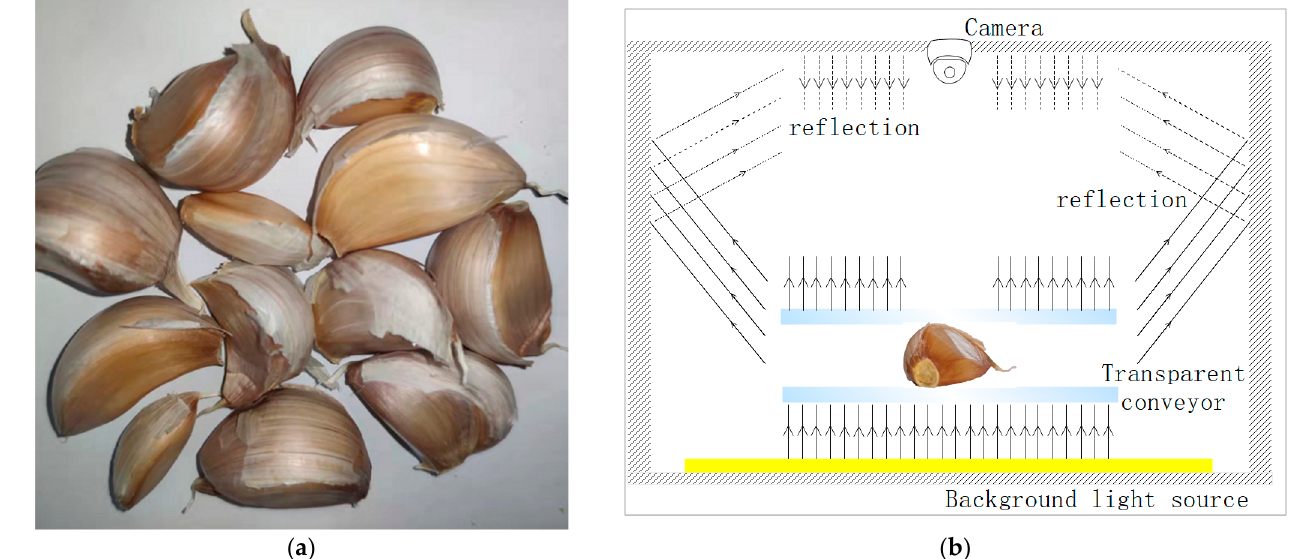
Figure 1. ( a ) Garlic clove samples and ( b ) image acquisition device.